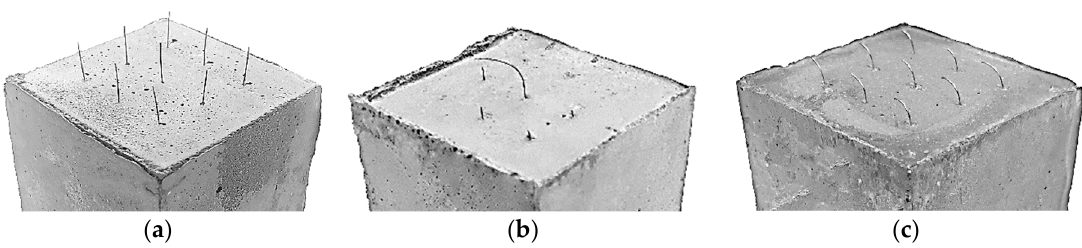
Figure 12. Test specimens VM after cyclic loading with a fibre orientation of ( a ) 90°, ( b ) 60°, and ( c ) 30°.